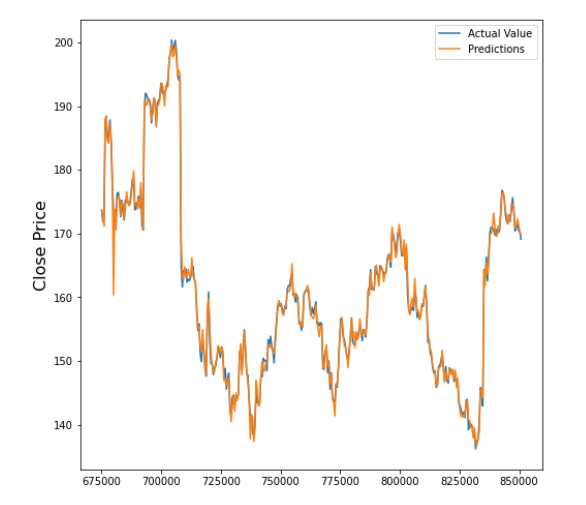
Figure 6. Prediction of Close price using ANN Convolutional Neural